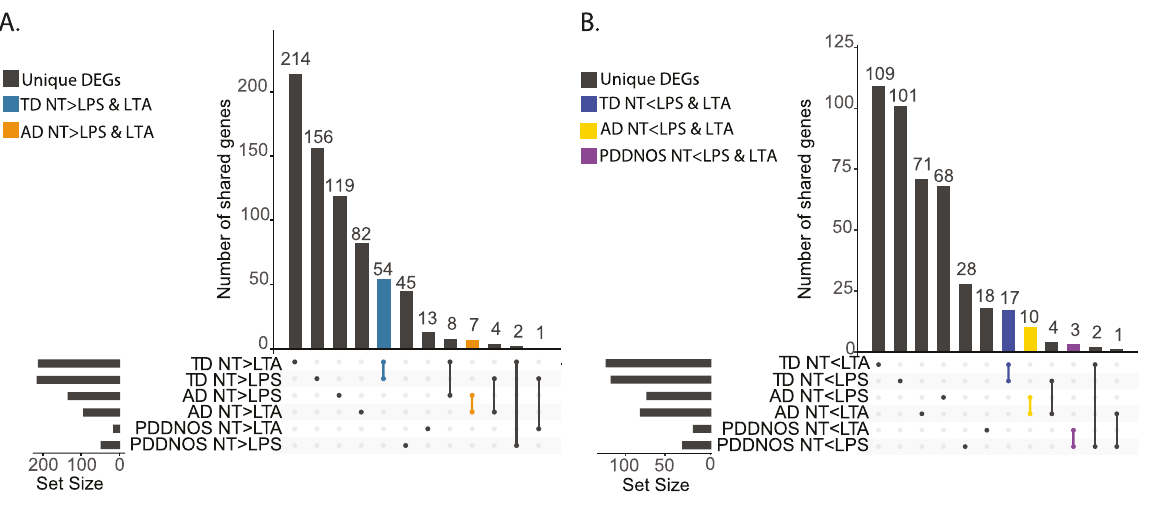
Fig. 3 Overlap of unique DEGs for monocyte stimulations in ASD compared to TD. A Upset plot of genes that are downregulated in response to LPS or LTA.The majority of genes that are regulated in response to LTA and LPS are not shared within a diagnosis (Gray). Genes with decreased expression in response to both treatments (NT > LPS and LTA) are labeled in blue (TD) and orange (AD). No overlapping genes were present in the PDDNOS group. See Table S8 for statistics and full gene lists. B Upset plot of genes that are upregulated in response to LPS or LTA. The majority of genes that are regulated are not shared within a diagnosis (Gray). Genes with increased expression in response to both treatments (NT < LPS & LTA) are labeled in blue (TD), yellow (AD) and purple (PDDNOS). See Table S8 for statistics and full gene lists. AD: autistic disorder, TD: typical developing controls, PDD/NOS: pervasive development disorder not otherwise speci fi ed, NT: no treatment, LPS: lipopolysaccharide, LTA: lipoteichoic